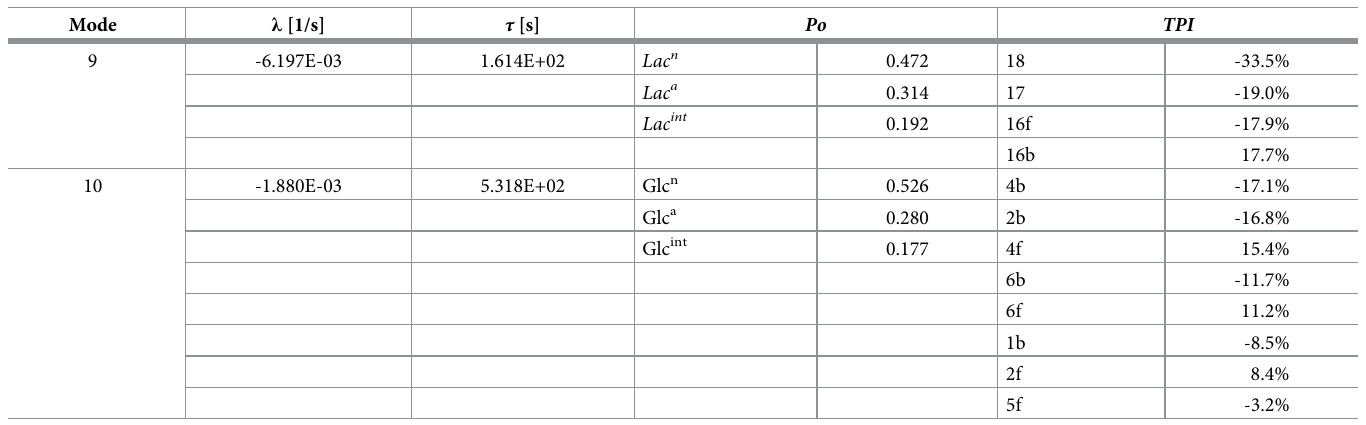
Table 3. CSP diagnostic tools for the 2 active modes in the ANLS